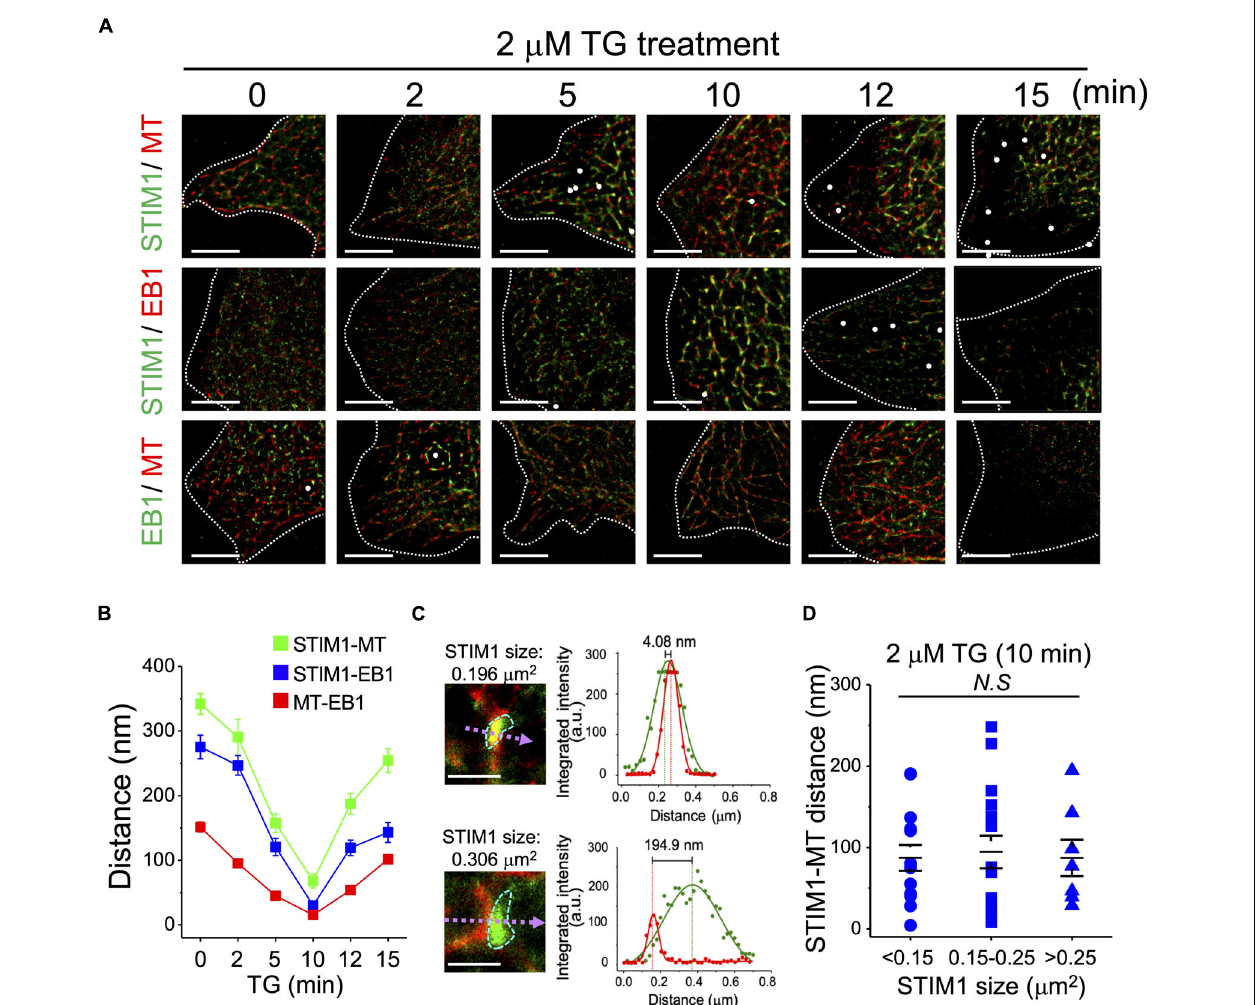
FIGURE 3 | End-binding protein 1-dependent coupling of STIM1 and microtubules in SOCE activation. (A) Representative dSTORM images showing the intracellular distributions of STIM1, α -tubulin and EB1 in TG-induced SOCE of SiHa cells. Dashed line, cell periphery. White dots, TetraSpeck microspheres. Scale bar, 5 µ m. (B) The distances between STIM1- α -tubulin, STIM1-EB, and α -tubulin-EB1 were analyzed using line fitting from the raw localization data. The full width at half-maximum (FWHM) was calculated from the resulting histogram, and calculated the molecular distance by minus the peak-to-peak distance ( Supplementary Figure 4 ). Each value represents mean ± SEM from at least five cells of three independent experiments. (C) (Left) dSTORM images of STIM1 (green) and α -tubulin (red) after TG treatment quantified using MetaMorph. (Right) Dot, fluorescent intensity of STIM1 (green) and α -tubulin (red) along the dashed line in the ROI image. Line, Gaussian fit of fluorescent intensity. Dashed line, the highest fluorescent intensity, representing the molecular center. (D) Quantitative analyses of STIM1 size and STIM1-microtubule distance after 10 min of TG treatment. Each value represents mean ± SEM from at least six cells of three independent experiments. Compared by one-way ANOVA with a Dunnett’s post hoc test. N.S.,